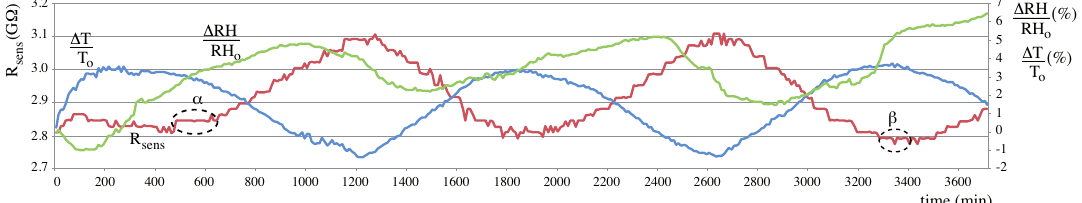
Figure 9. Steady-state analysis #2. Sample B (Maritime pine) measurements during 62 h. Red: R sens , blue: temperature variation percentage, green: ambient humidity variation percentage.